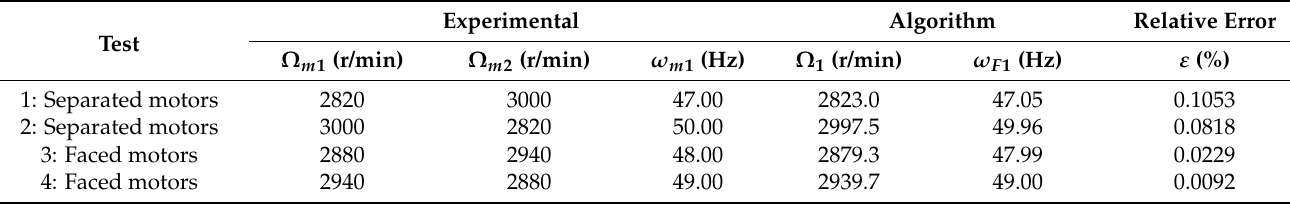
Table 15. No load coupled to the motor shaft: estimation of the reference motor speed, the frequency, and the relative error obtained in each test.